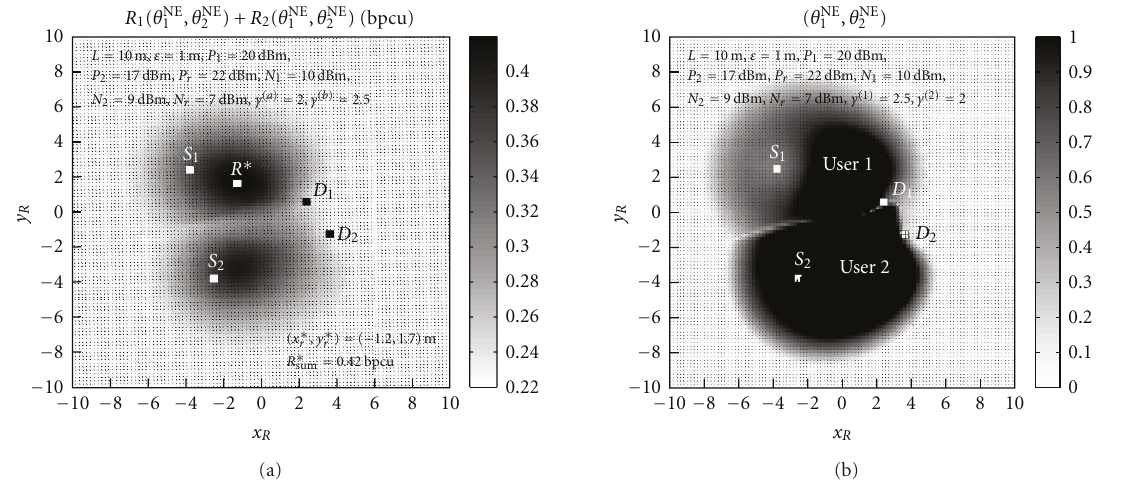
Figure 6: ZDSAF relaying protocol, full power regime. L = 10m, ε = 1m, P 1 = 20 dBm, P 2 = 17dBm, P r = 22dBm, N 1 = 10dBm, N 2 = 9 dBm, N r = 7 dBm, γ (1) = 2 . 5, and γ (2) = 2. (a) Achievable network sum-rate at the NE as a function of ( x R , y R ) ∈ [ − L , L ] 2 (the optimal relay position ( x ∗ R , y ∗ R ) = ( − 1 . 2,1 . 7) lies on the segment between S 1 and D 1 ). (b) Power allocation policies at the NE ( θ NE 1 , θ NE 2 ) as a function of ( x R , y R ) ∈ [ − L , L ] 2 (the regions where the users allocate their power to IRC are almost nonoverlapping).